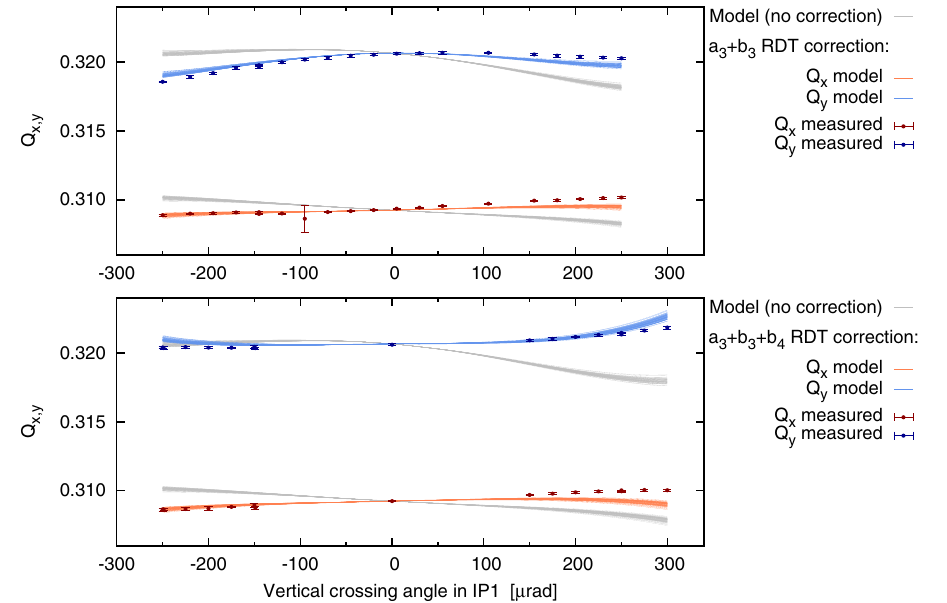
¼ 0 . 6 m. Two scans IP 1